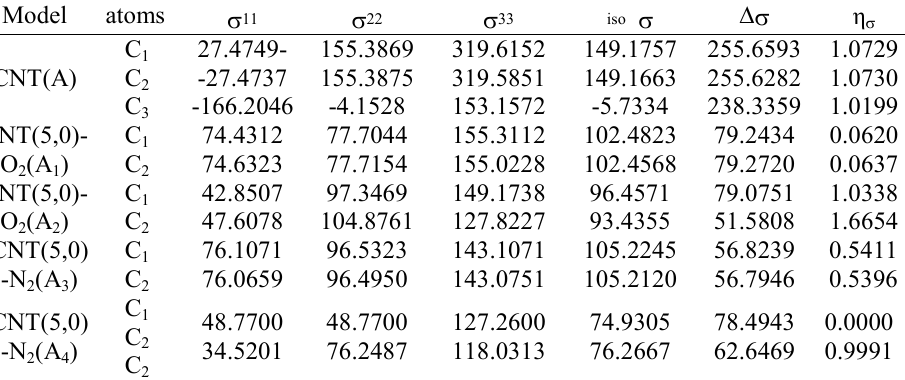
–CNT, O –CNT system 2 2